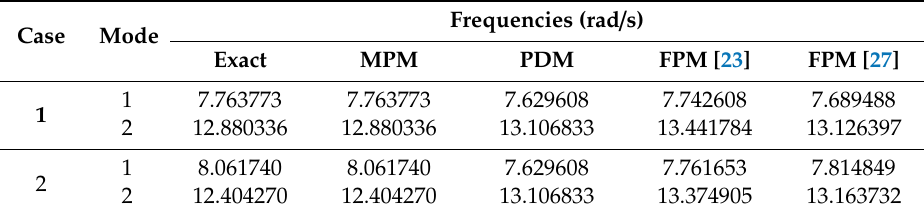
Table 2. The damping ratios of the 2 DOFs